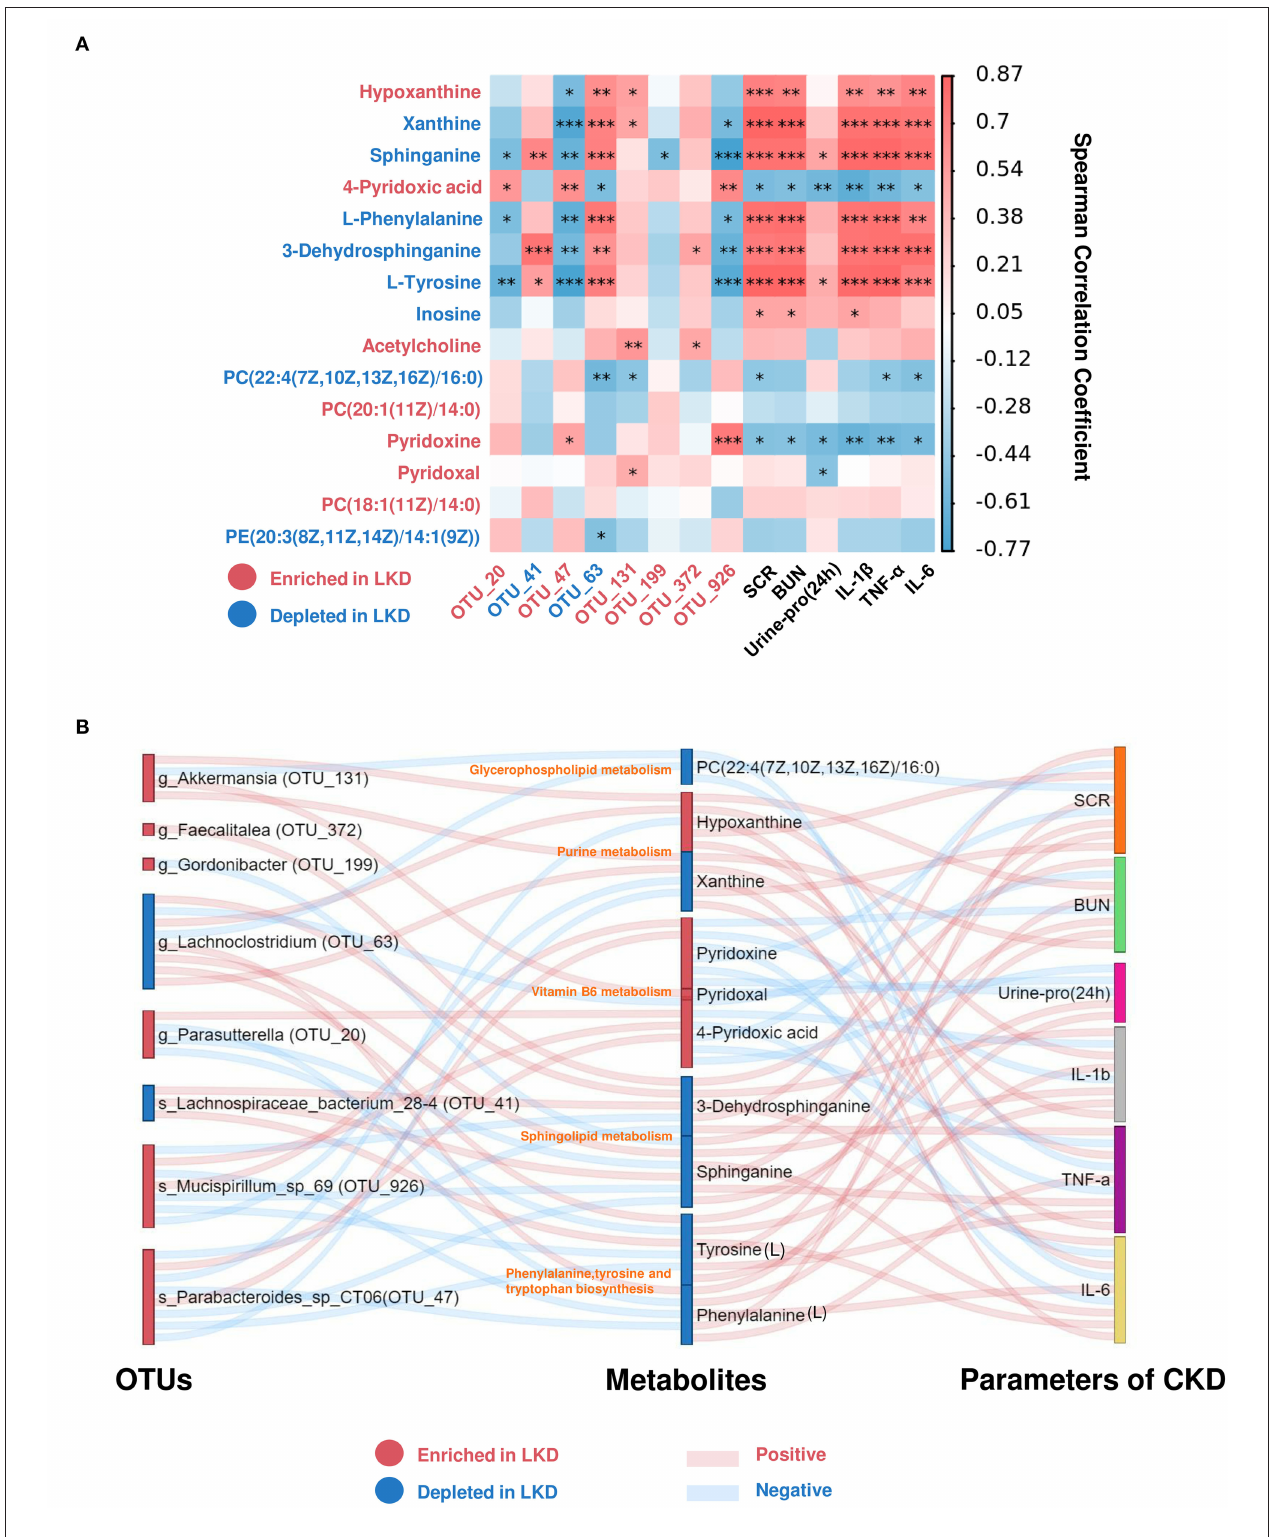
FIGURE 8 | Spearman’s correlations between differential metabolites and OTUs associated with LKD or parameters for CKD. (A) Heatmap showing Spearman’s correlation between differential metabolites and OTUs associated with LKD or parameters for CKD. The IDs of metabolites or OTUs are highlighted in red (enriched in LKD) and blue (depleted in LKD). * p < 0.05, ** p < 0.01, *** p < 0.001. (B) Sankey plot was used to visualize the relationship among the differential OTUs and serum